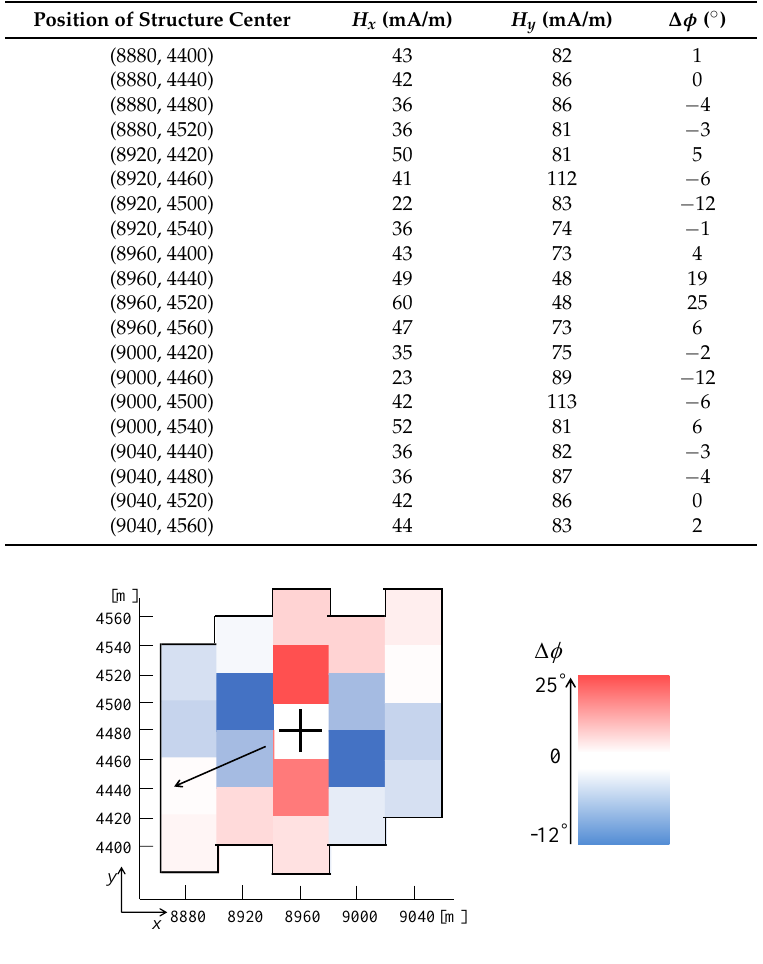
Figure 11. Color-coded azimuth error due to the presence of a nearby conducting structure having a height of 60 m and a square cross-section of 40 m ˆ 40 m for the case of true azimuth φ equal to 26.6 ° (tan ´ 1 φ = 0.5).